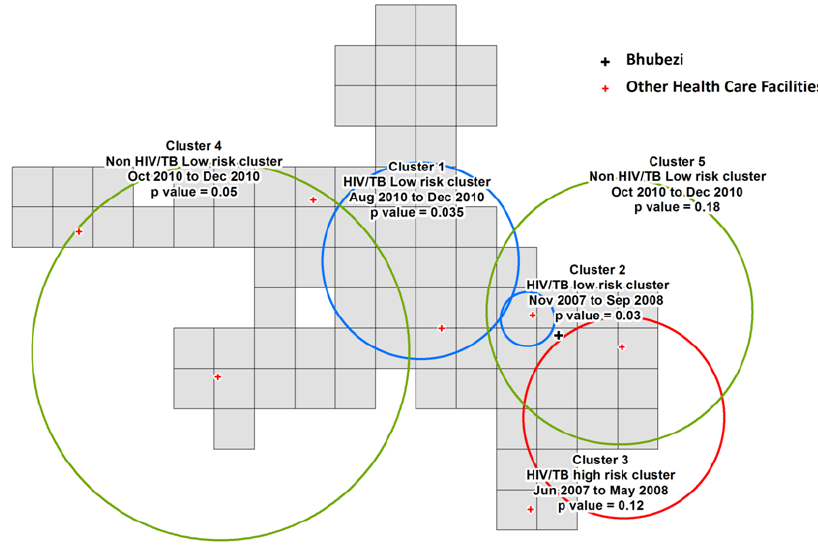
Figure 7. Spatio–temporal clusters with significantly raised or lowered rates of deaths due to HIV/TB and Non HIV/TB over the period 1 Jan 2007 to 31 Dec